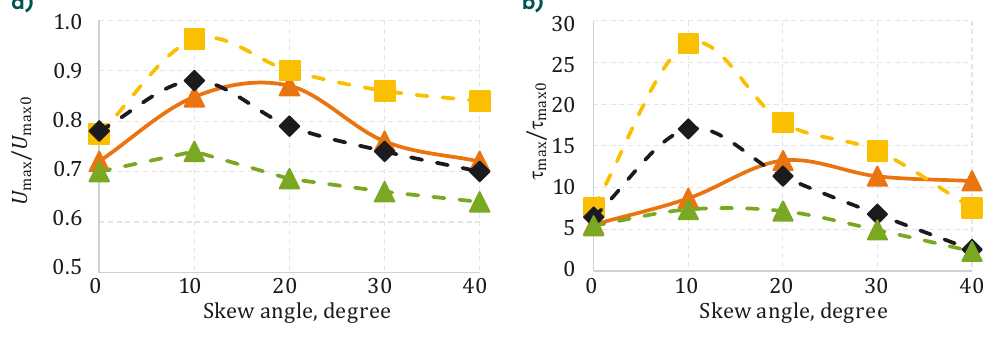
Figure 22. Diagram of velocity and bed shear stress changes for different patterns a) Maximum velocity diagram around the flow-splitting abutment: a) maximum velocity diagram around the flow-guiding abutment; b) maximum shear stress diagram around the flow-guiding